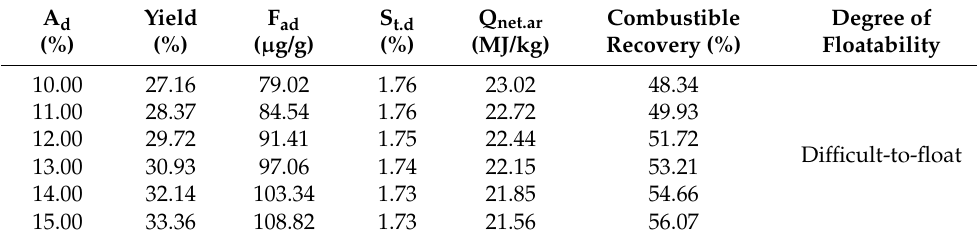
Figure 6. Ash contents, fluorine contents, sulfur contents, and net calorific values for different products of release flotation tests. Table 4. The degrees of floatability of flotation concentrates at different given ash contents 1